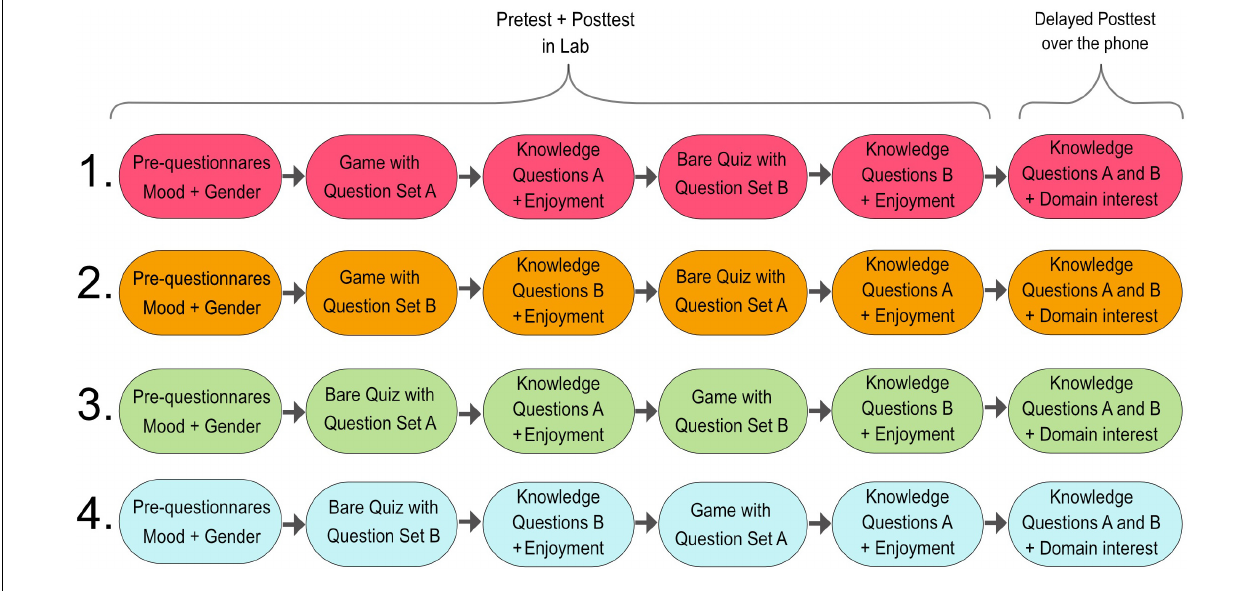
FIGURE 2 | Design of the intervention and procedure.